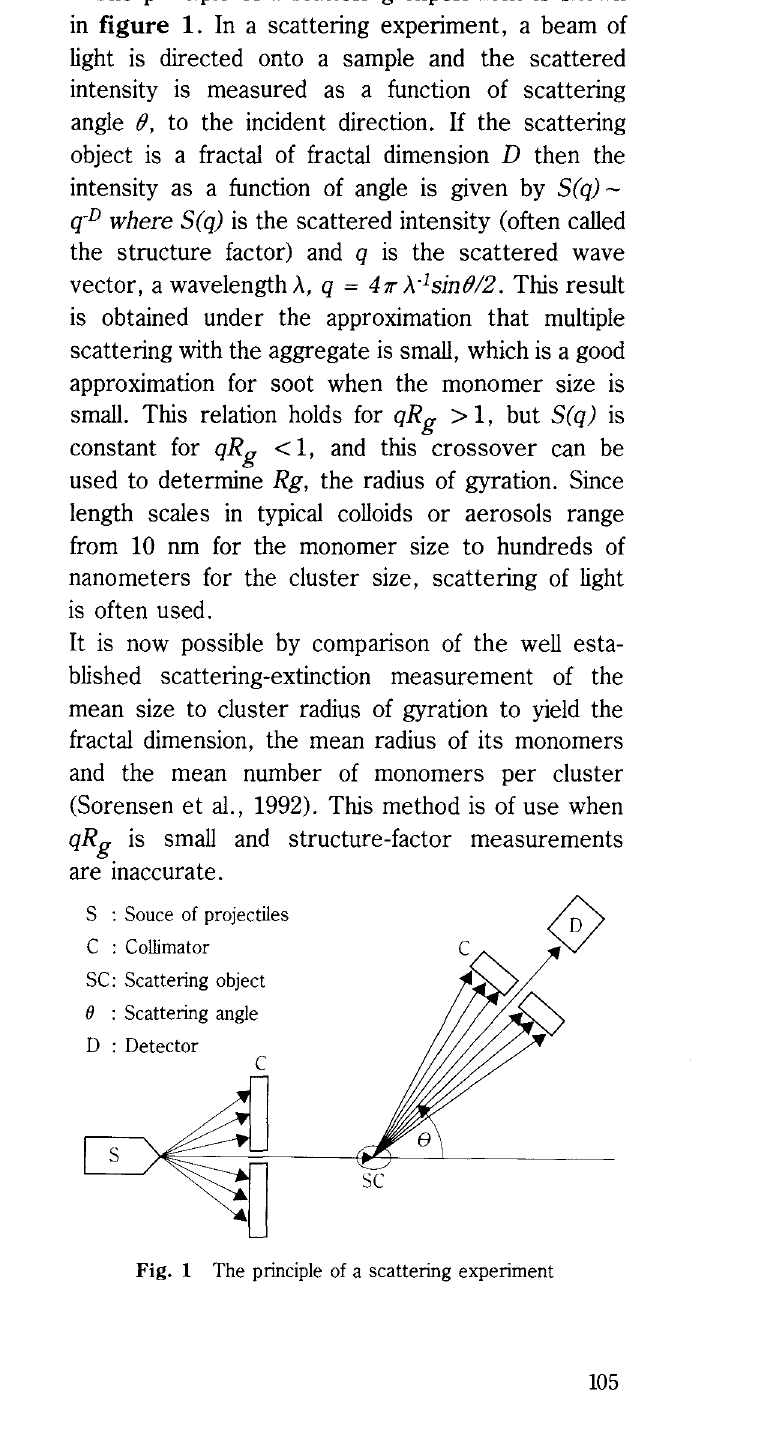
Fig. 1 The principle of a scattering